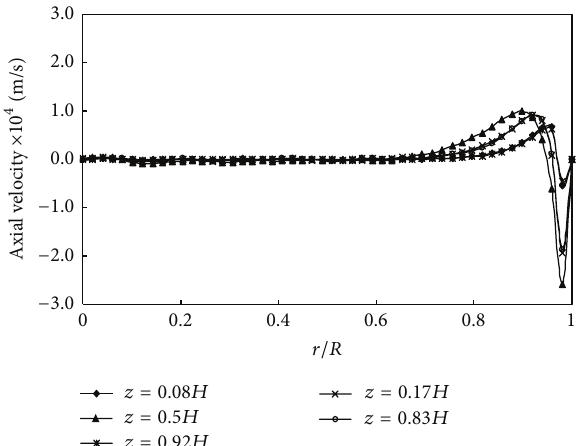
Figure 6: Contours of stream function field.